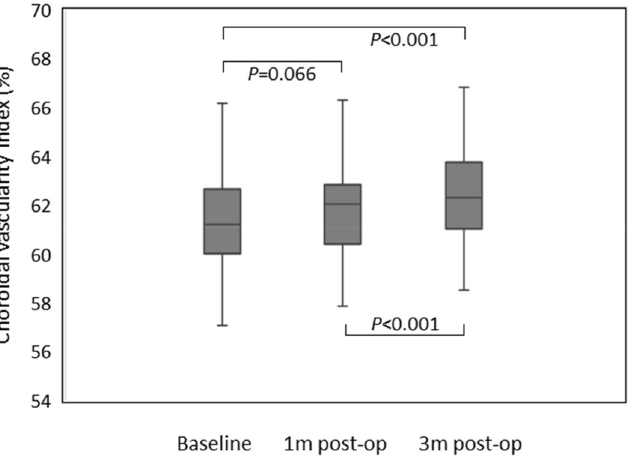
Figure 1. Choroidal vascularity index in Phaco + ppV group evaluated by repeated measures ANOVA tests and post hoc analysis. Increase in choroidal vascularity index was statistically significant from baseline to 3 months post-op and from 1 month post-op to 3 months post-op.